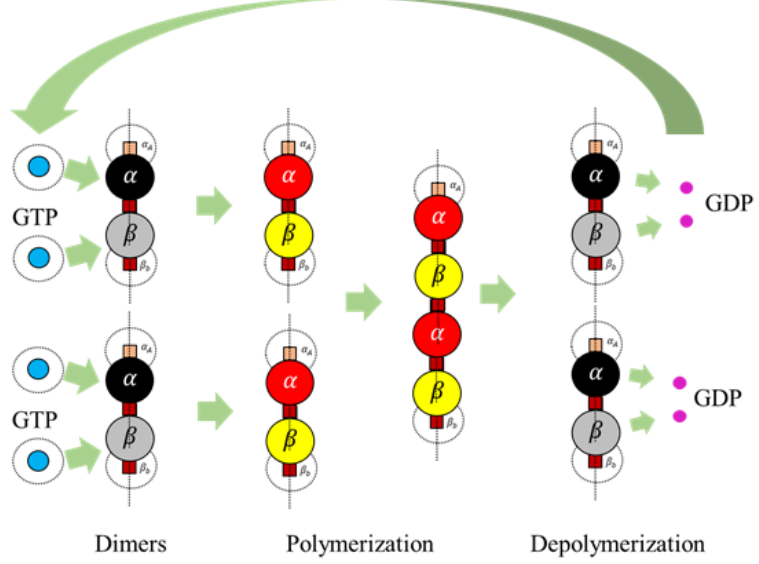
Figure 8. The complete cycle from activation of dimers to polymerization and depolymerization applying extended rules.